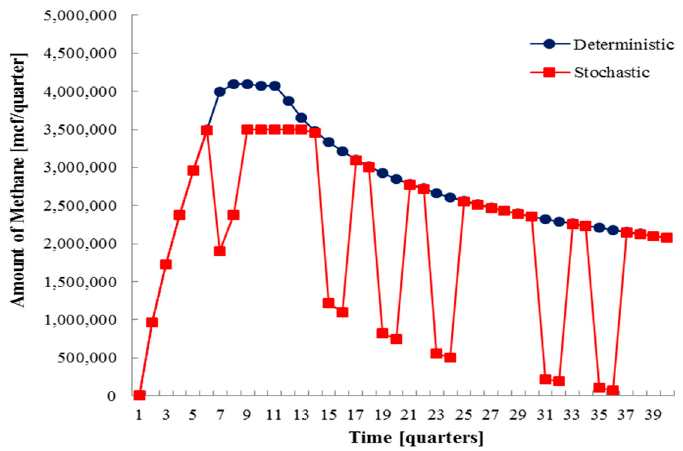
Figure 13. Total amount of natural gas sold in Market 1 for both deterministic (base case) and stochastic cases during the planning horizon.